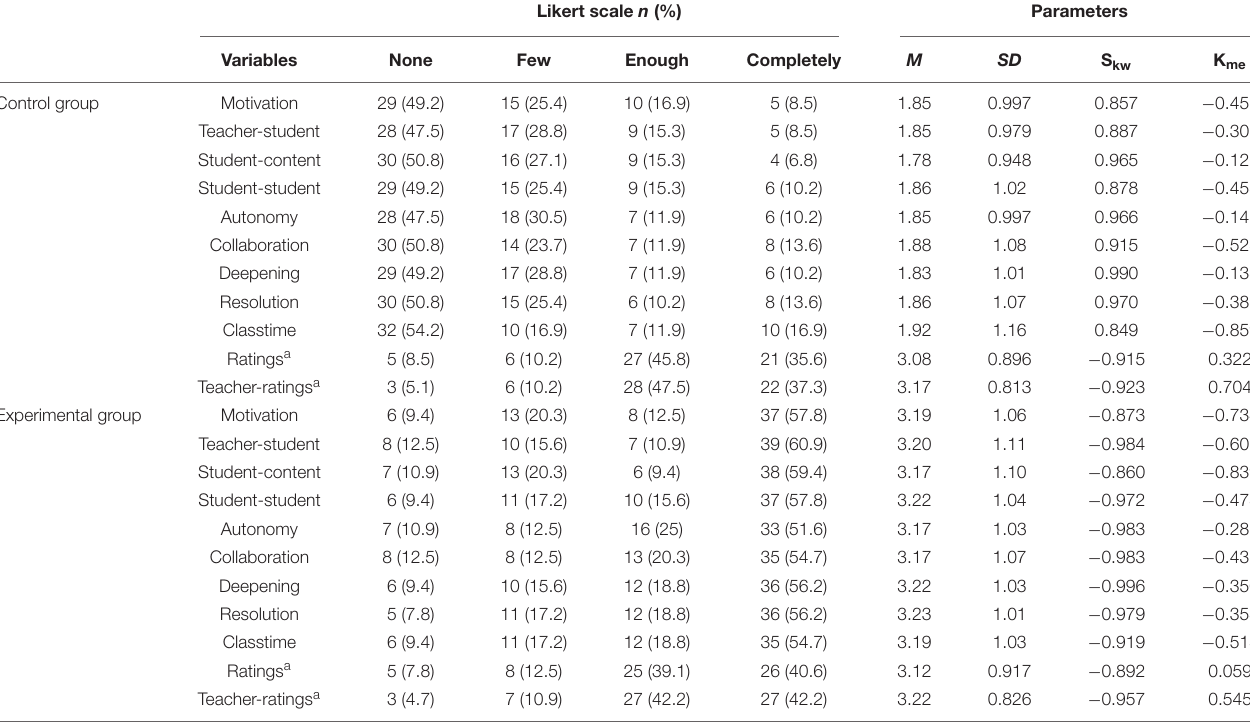
TABLE 2 | Results obtained for the variables of study in GC and ME of Master of Teaching